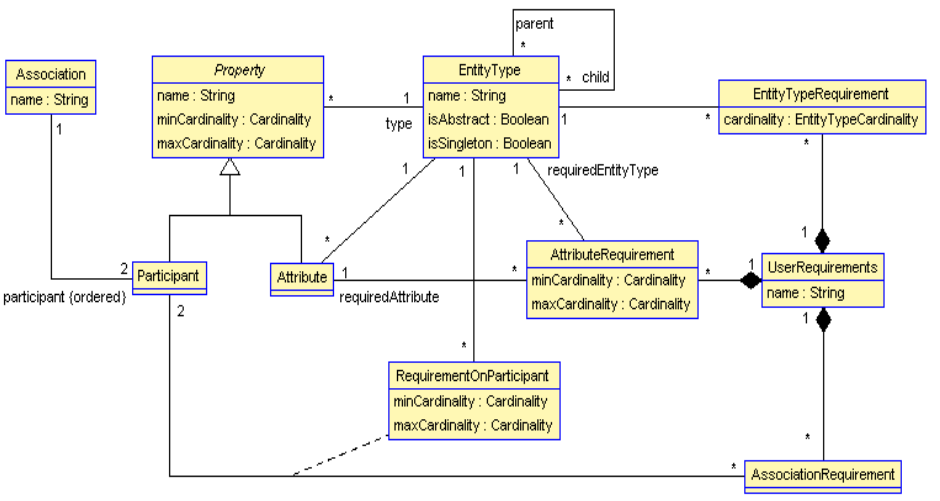
Figure 3. Extension of the metamodel of Figure 1 with user